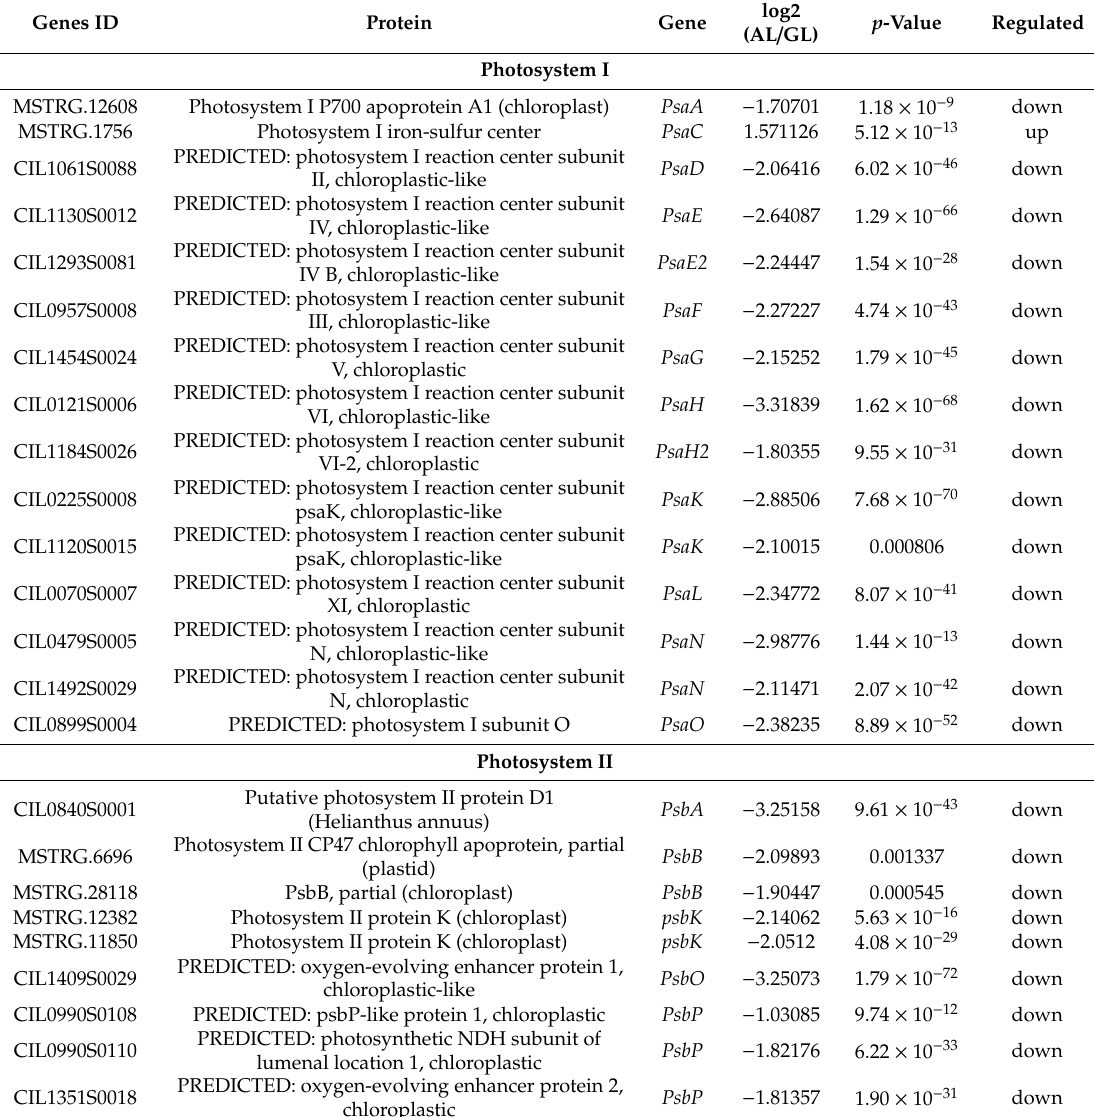
Table 5. Identified di ff erentially expressed genes involved in the photosynthesis pathway. Genes ID Protein Gene